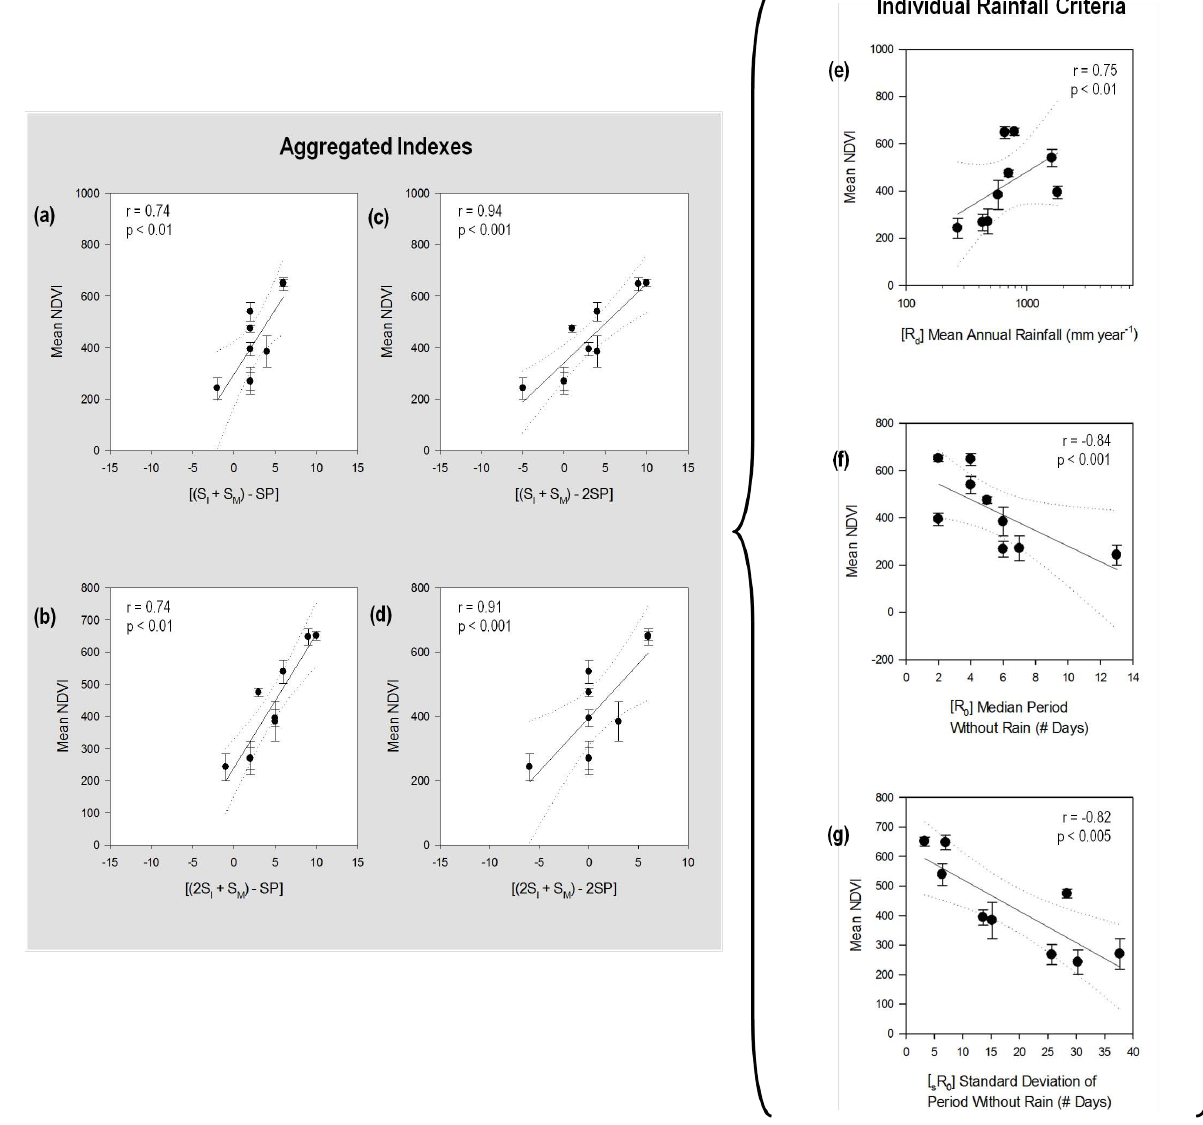
Fig. 3. Mean NDVI in relation to aggregated sensitivity indexes (shaded, a–d ) and individual rainfall parameters (précis, e–g ). Refer to Fig. A1 for spatial distribution of NDVI across eastern